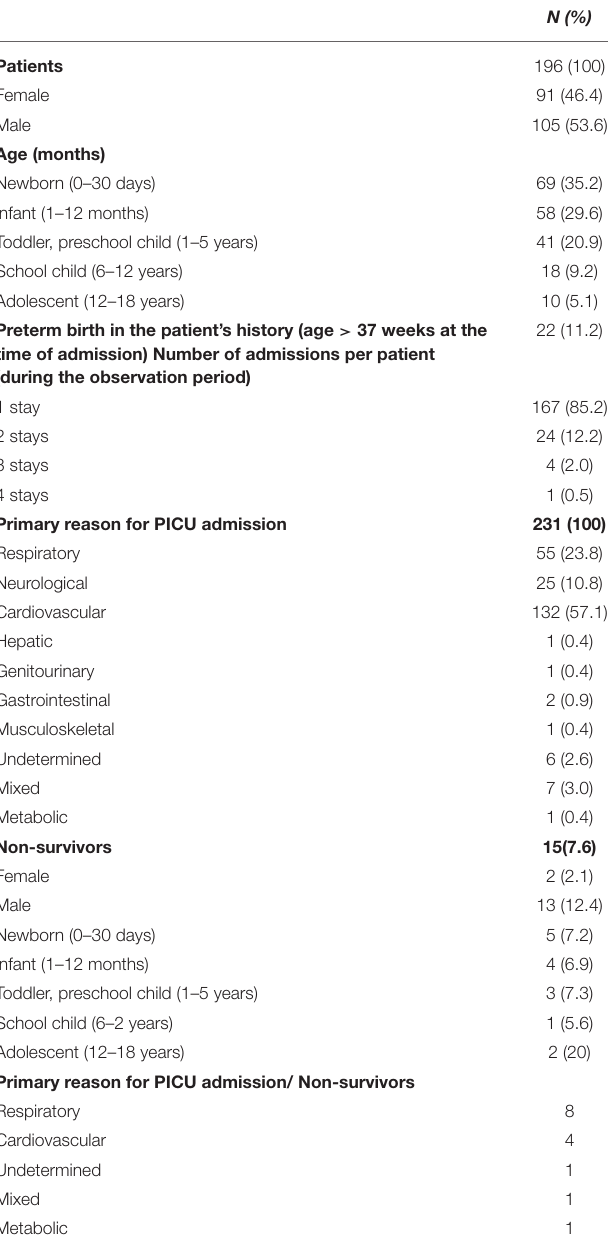
TABLE 2 | Descriptive statistic of the study population. In the study some patients were included more than one time as each admission was assessed.